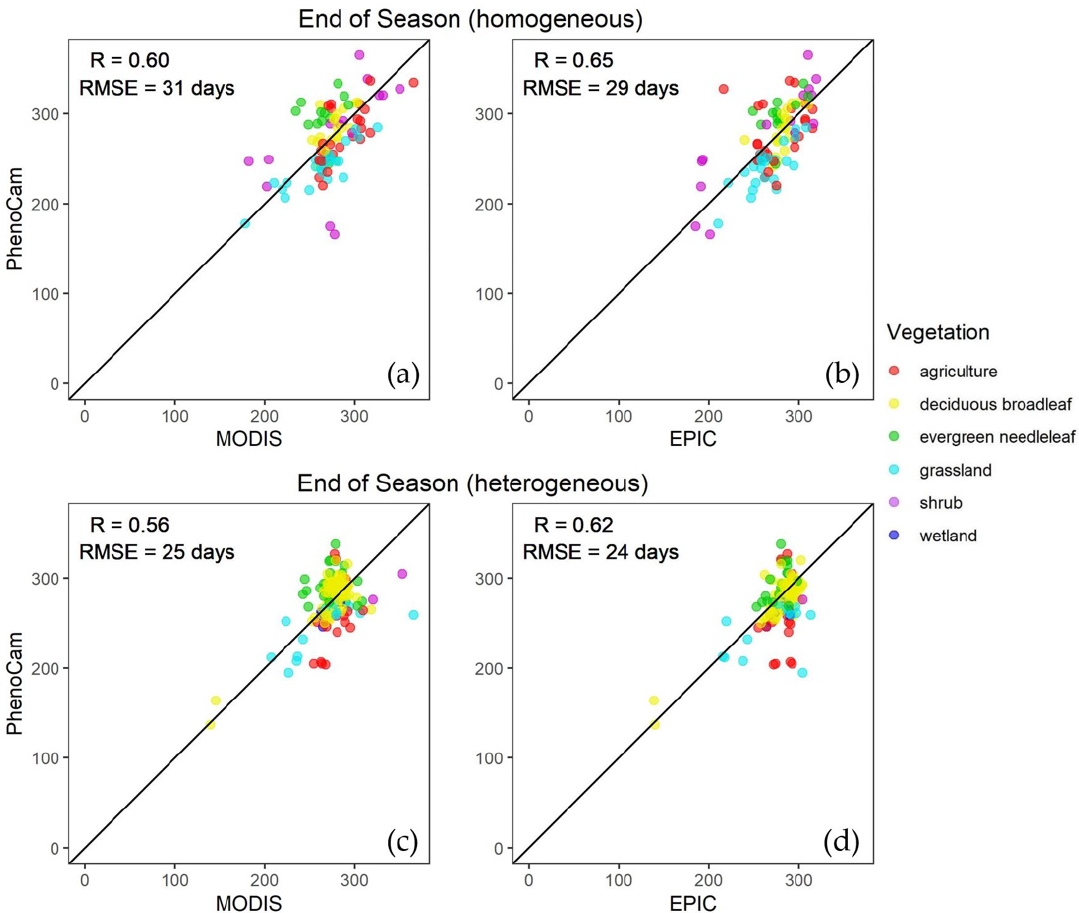
Figure 13. The correlation of EOS (in days) for PhenoCam and ( a ) MODIS and ( b ) EPIC for homogeneous sites only, and PhenoCam and ( c ) MODIS and ( d ) EPIC for heterogeneous sites only during 2016–2018.